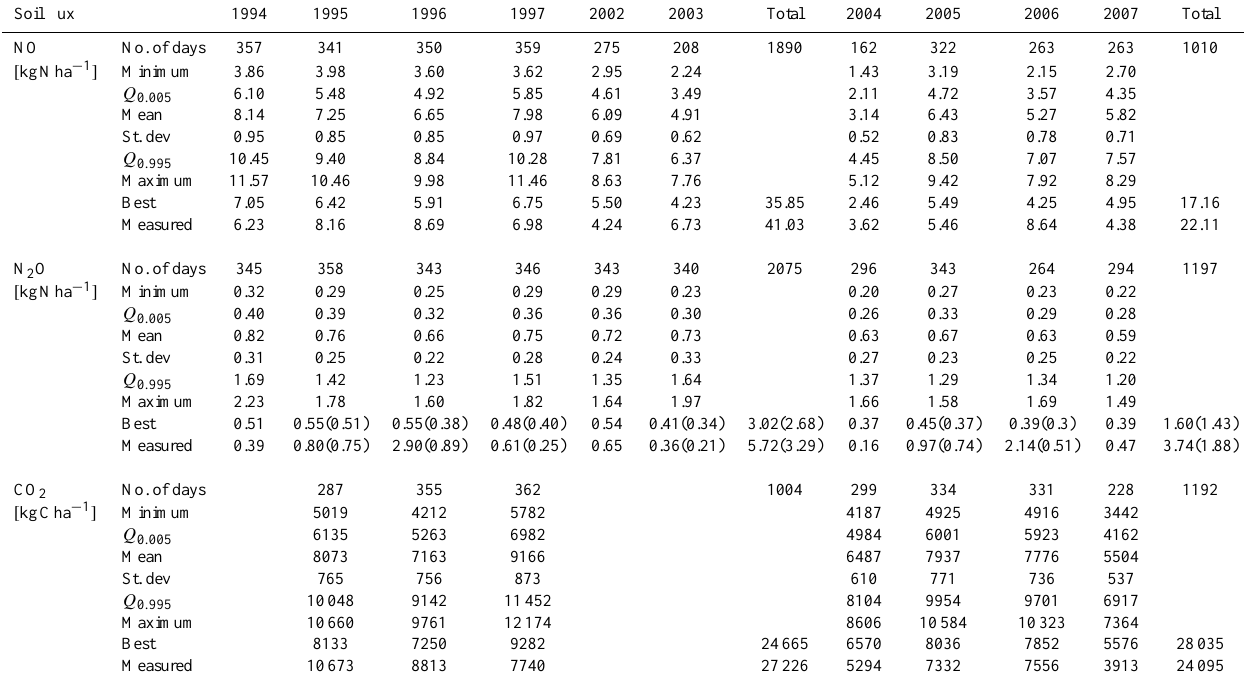
Table 3. Summary of cumulated measured and simulated emissions of NO, N 2 O and CO 2 . Simulated fluxes were only cumulated if corre- sponding periods with observations were available. Values in Brackets are calculated after freeze-thaw events.